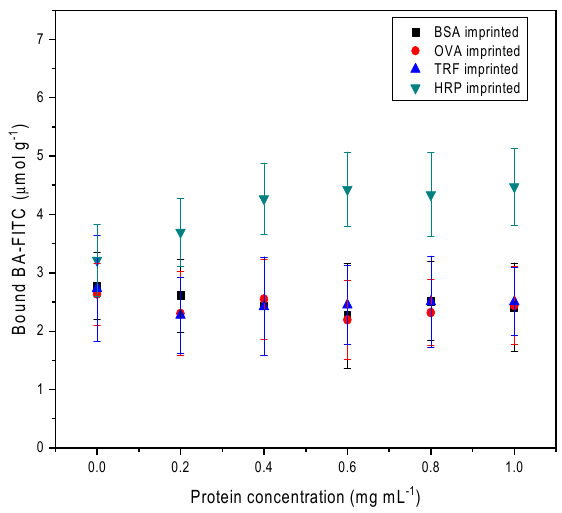
Figure 5. Detection of protein binding to imprinted particles using BA–FITC as a fluorescence probe. The MIP nanoparticles (3 mg) were first incubated with their corresponding protein templates (0.2–1.0 mg mL − 1 ). After this step, BA–FITC was added, and the bound BA–FITC was measured using a fluorescence spectrometer.